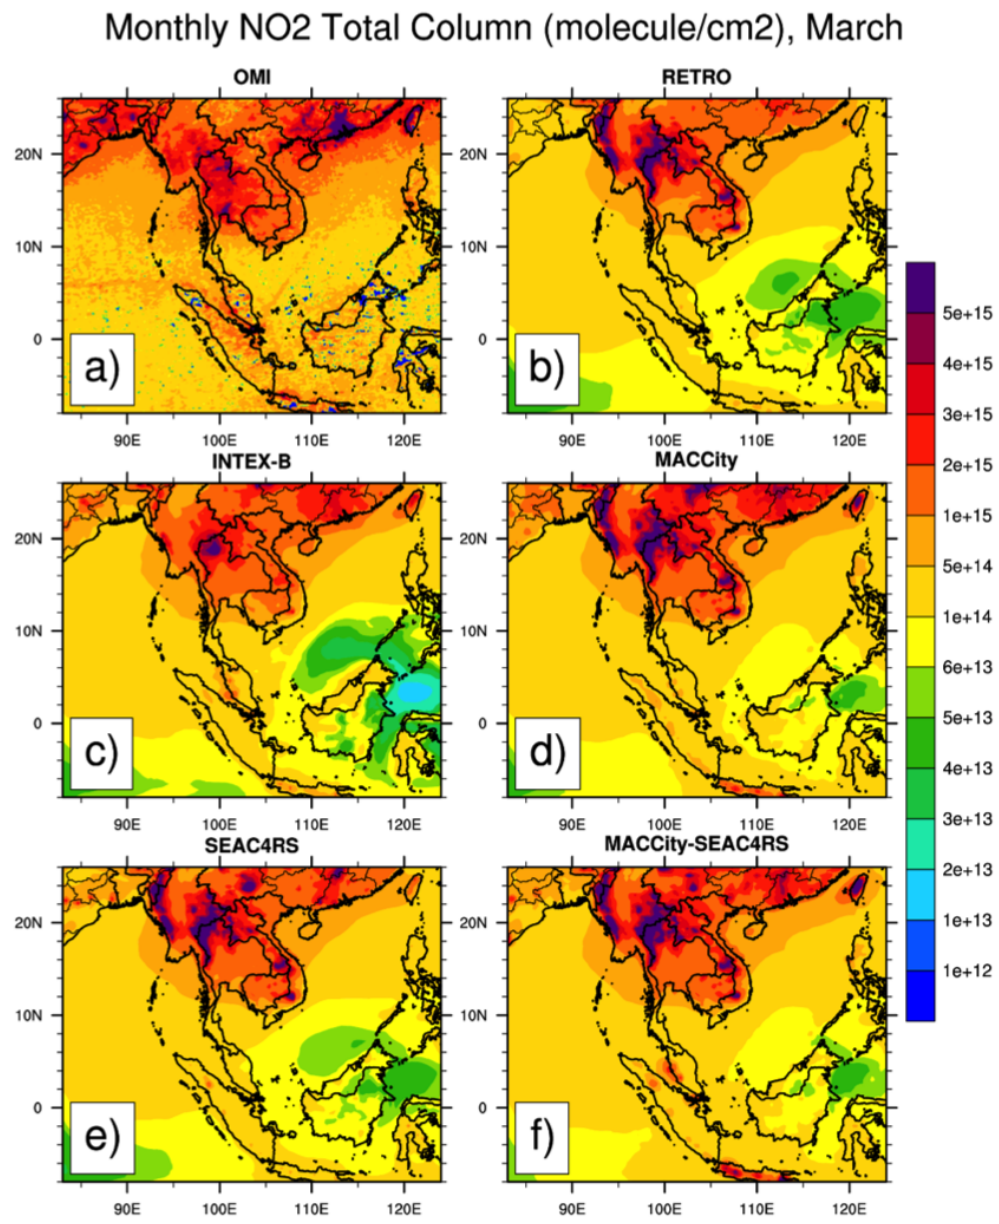
Figure 14. March 2008 monthly NO 2 total column (a) OMI, (b) WRF-Chem + RETRO, (c) WRF-Chem + INTEX-B, (d) WRF-Chem + MACCity, (e) WRF-Chem + SEAC4RS, and (f) WRF-Chem +